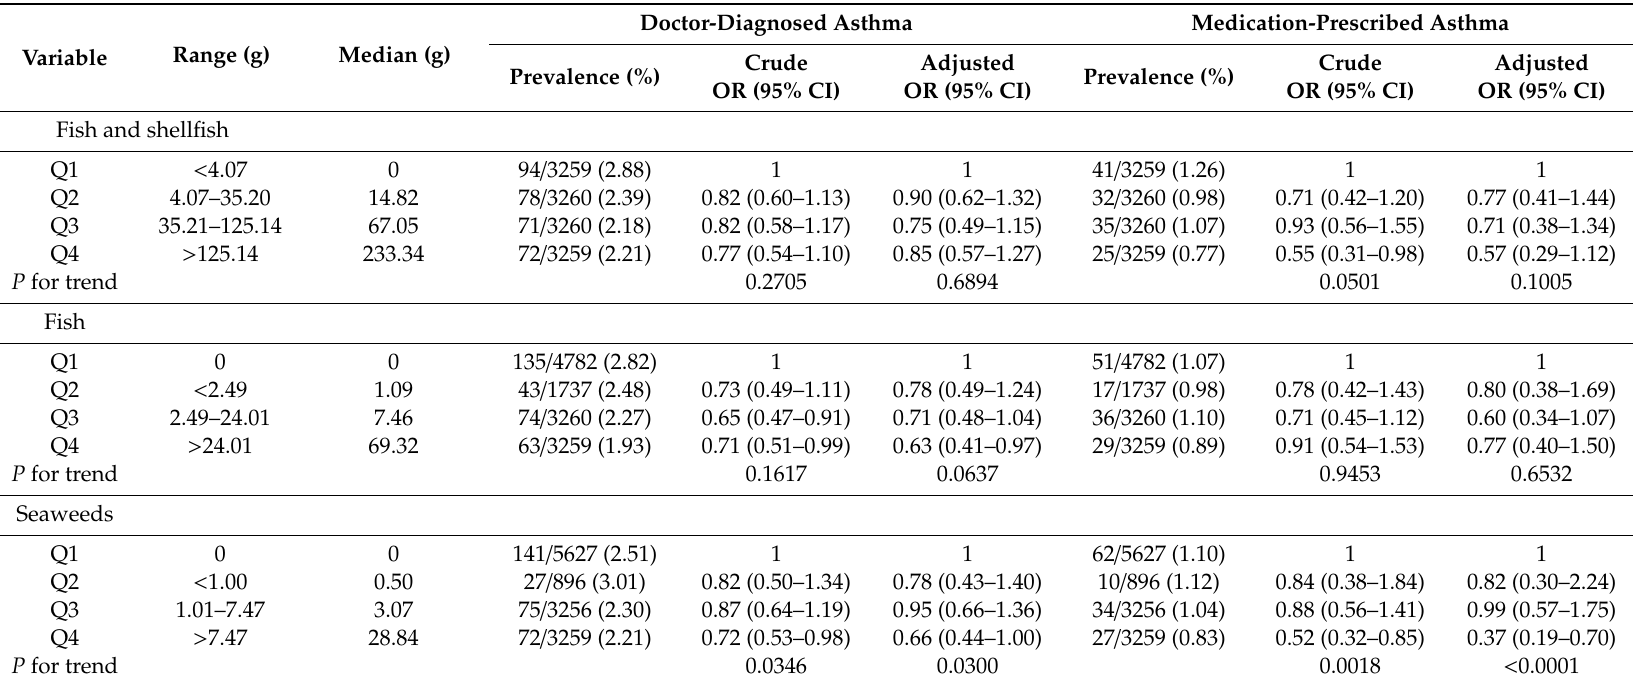
Table 3. Association between fish and seaweeds intake and